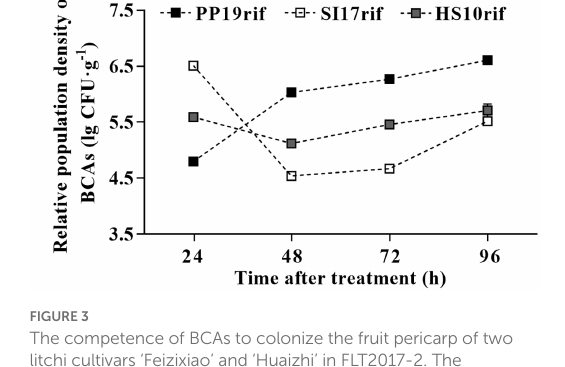
fruit from 0 to 60 h but had slightly lower levels thereafter (Figure 4C). Anthocyanin content varied in all samples over the time course, with peak accumulation at 60 h (control and PP19) or 48 h (Sl17). Anthocyanin contents were higher in fruit treated with strains PP19 or SI17 than in mock-treated control fruit except at 48, 60, and 84 h (Figure 4D). ANT